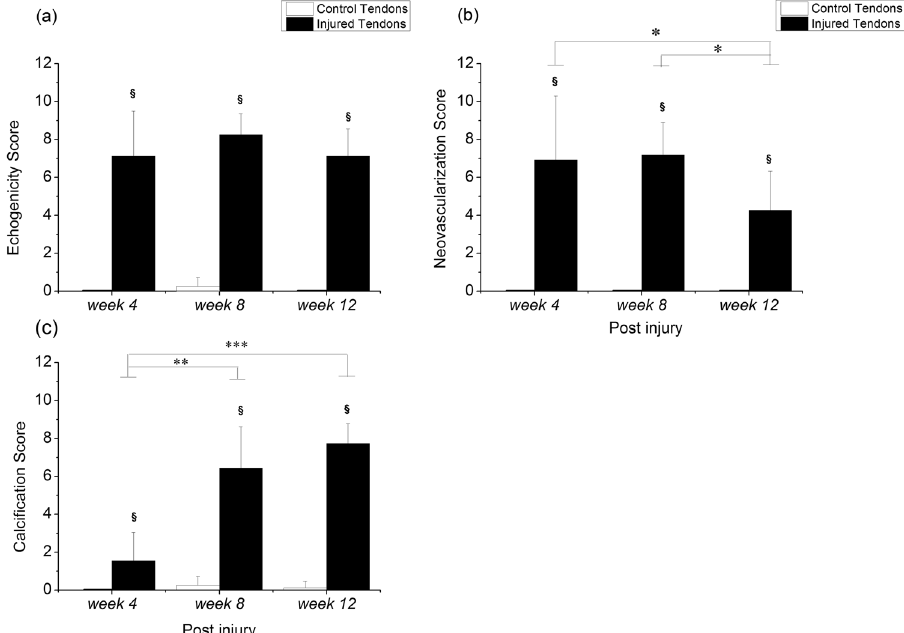
Figure 3. Ultrasound feature scores in Achilles tendons. § Compared with the control tendons; * / ** / *** compared within the injured tendons; §/ * p < 0.05, ** p < 0.01, *** p <